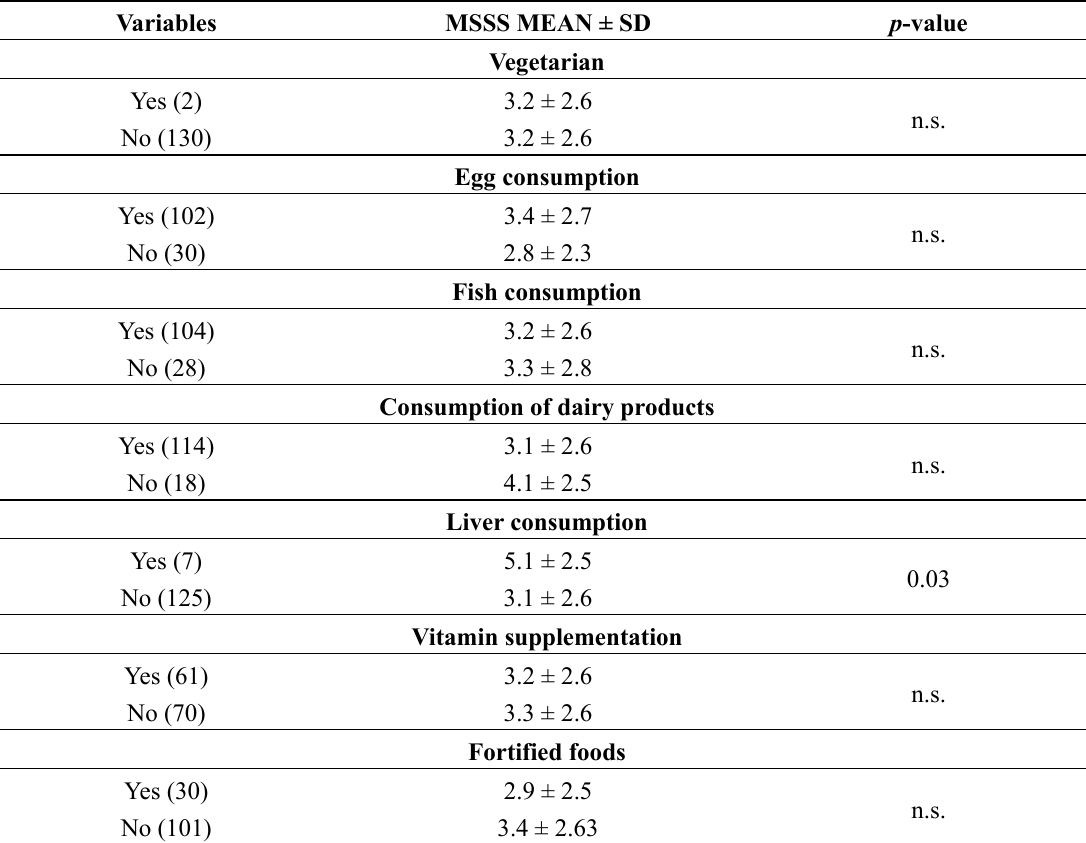
Table 4. Diet and MS Severity (MSSS value).